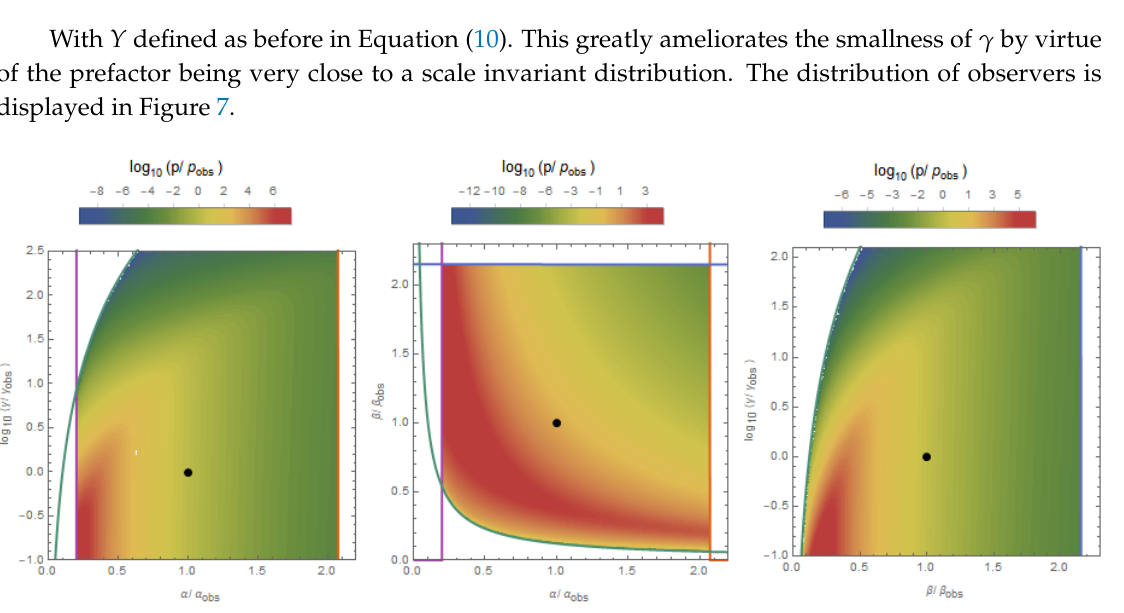
Figure 7. Distribution of observers from imposing the entropy